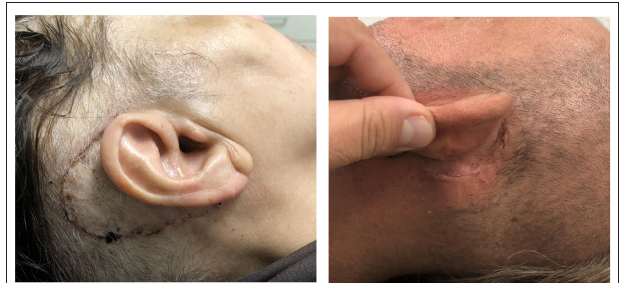
FIGURE 6 | Retroauricular incision. Left side is one of the first 3 cases (initial EAR2OS trial) and right side all other more recent cases (ARCI25